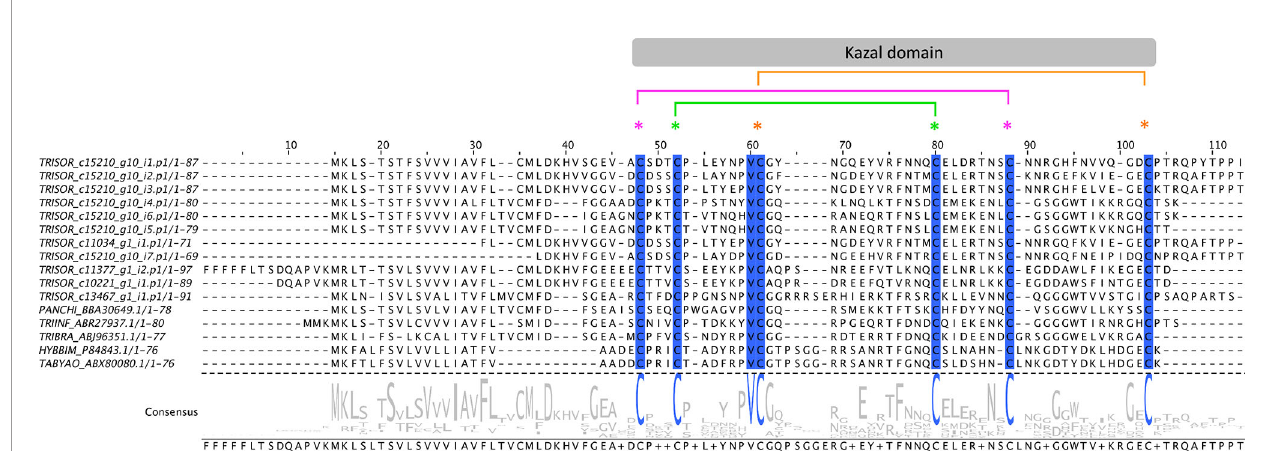
FIGURE 5 | The Kazal-type members from Triatoma sordida . Multiple sequence alignment of Kazal-type members extracted from T. sordida sialotranscriptome (TRISOR_ c15210_g10_i1.p1; TRISOR_ c15210_g10_i2.p1; TRISOR_ c15210_g10_i3.p1; TRISOR_ c15210_g10_i4.p1; TRISOR_ c15210_g10_i6.p1; TRISOR_ c15210_g10_i5.p1; TRISOR_ c11034_g1_i1.p1; TRISOR_ c15210_g10_i7.p1; TRISOR_ c11377_g1_i2.p1; TRISOR_ c10221_g1_i1.p1; TRISOR_ c13467_g1_i1.p1) and other homologous Kazal-type sequences from: Panstrongylus chinai (PANCHI_BBA30649.1); Triatoma infestans (TRIINF_ABR27937.1); Triatoma brasiliensis (TRIBRA_ABJ96351.1); Hybomitra bimaculata (HYBBIM_P84843.1); and Tabanus yao (TABYAO_ABX80080.1). The alignments indicate conserved residues in a blue scale background. The sequences are identi fi ed as described in the Methods section. The grey bar above indicates the Kazal domain region, with coloured asterisks showing the arrangement of the six conserved cysteines (C1:C5, C2:C4, C3:C6). Consensus sequence shows the frequency of amino acids in the multiple sequence alignment. The height of aminoacid symbols within the stack indicates the relative frequency of each amino acid at that position.